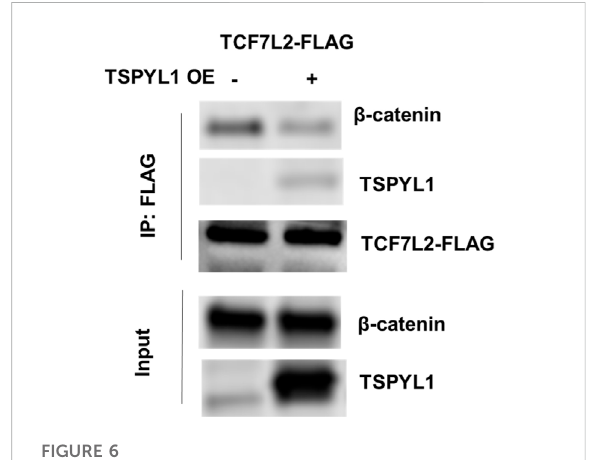
FIGURE 6 TSPYL1 blocks β -catenin binding with TCF7L2. Interaction of endogenous β -catenin with overexpressed TSPYL1 and TCF7L2- FLAG is shown. IP was conducted with whole-cell lysates of 293T cells transfected with TCF7L2-FLAG and an empty vector or TSPYL1 overexpression plasmid. TSPYL1 overexpression reduced β -catenin binding with TCF7L2.